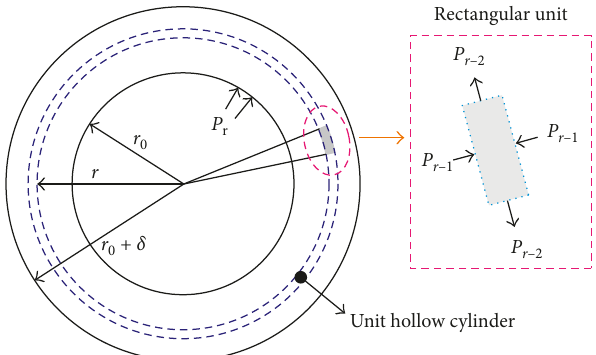
Figure 13: Unit division of the hollow